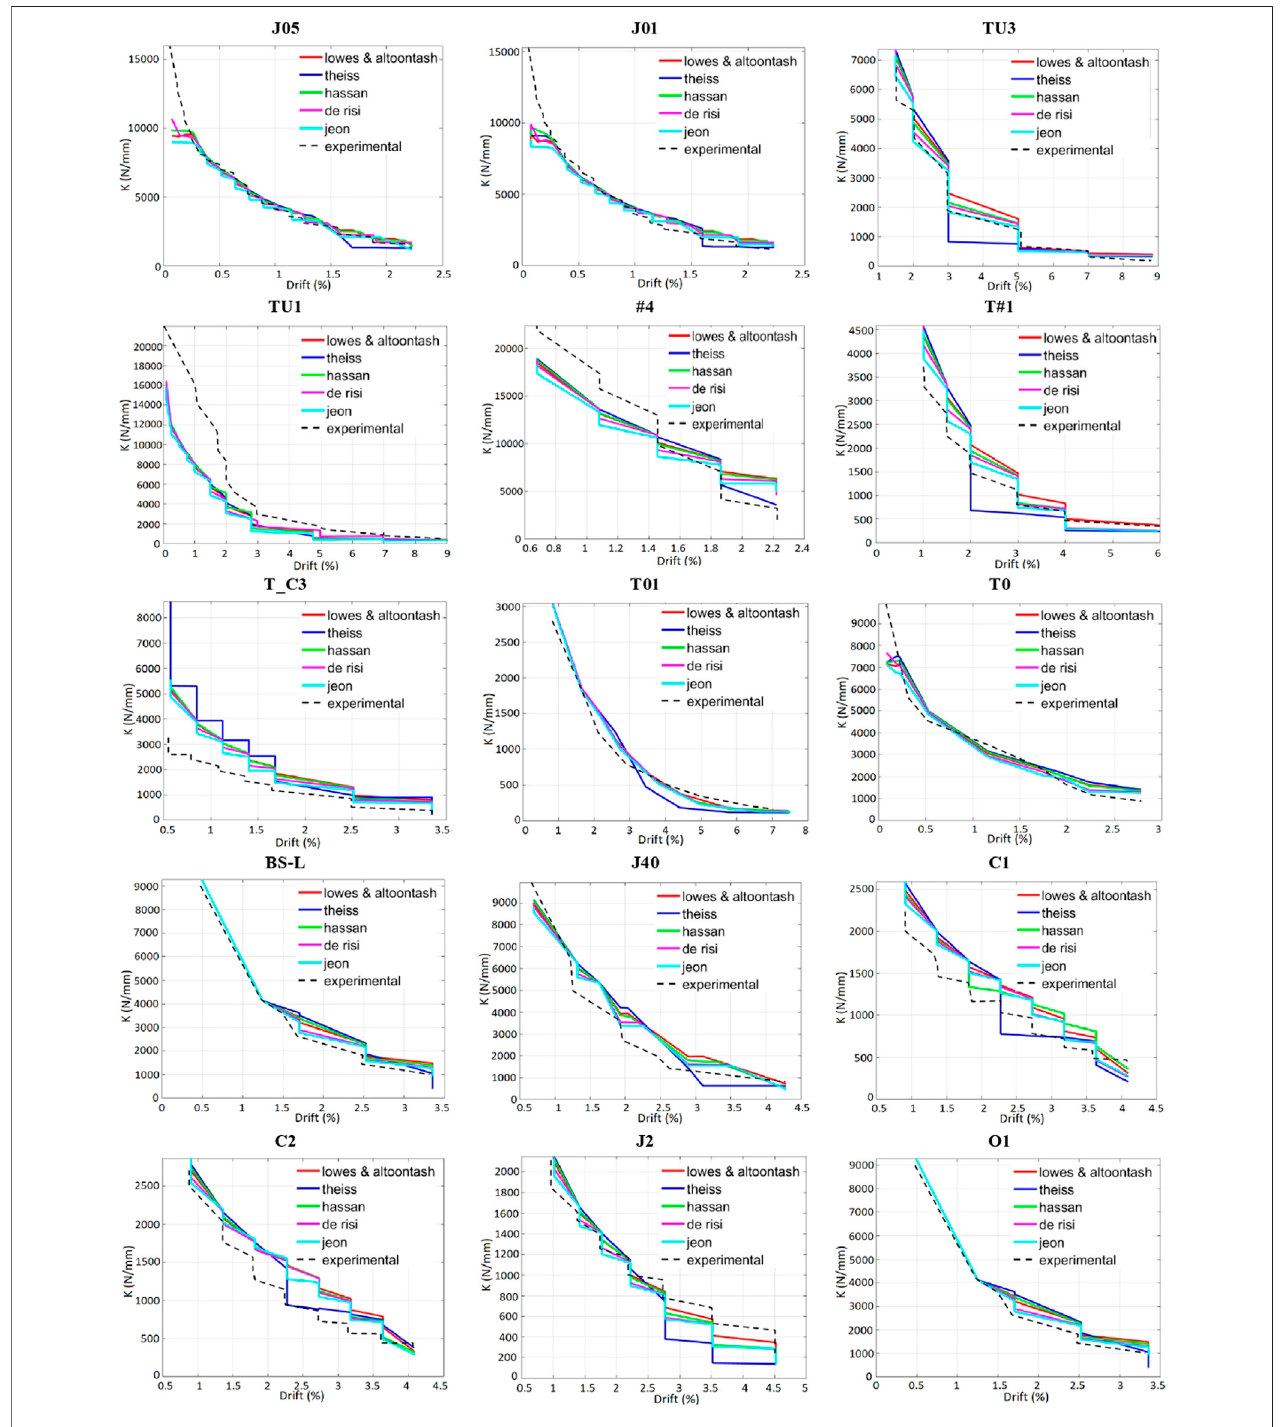
FIGURE 12 | Stiffness degradation: comparison among the literature